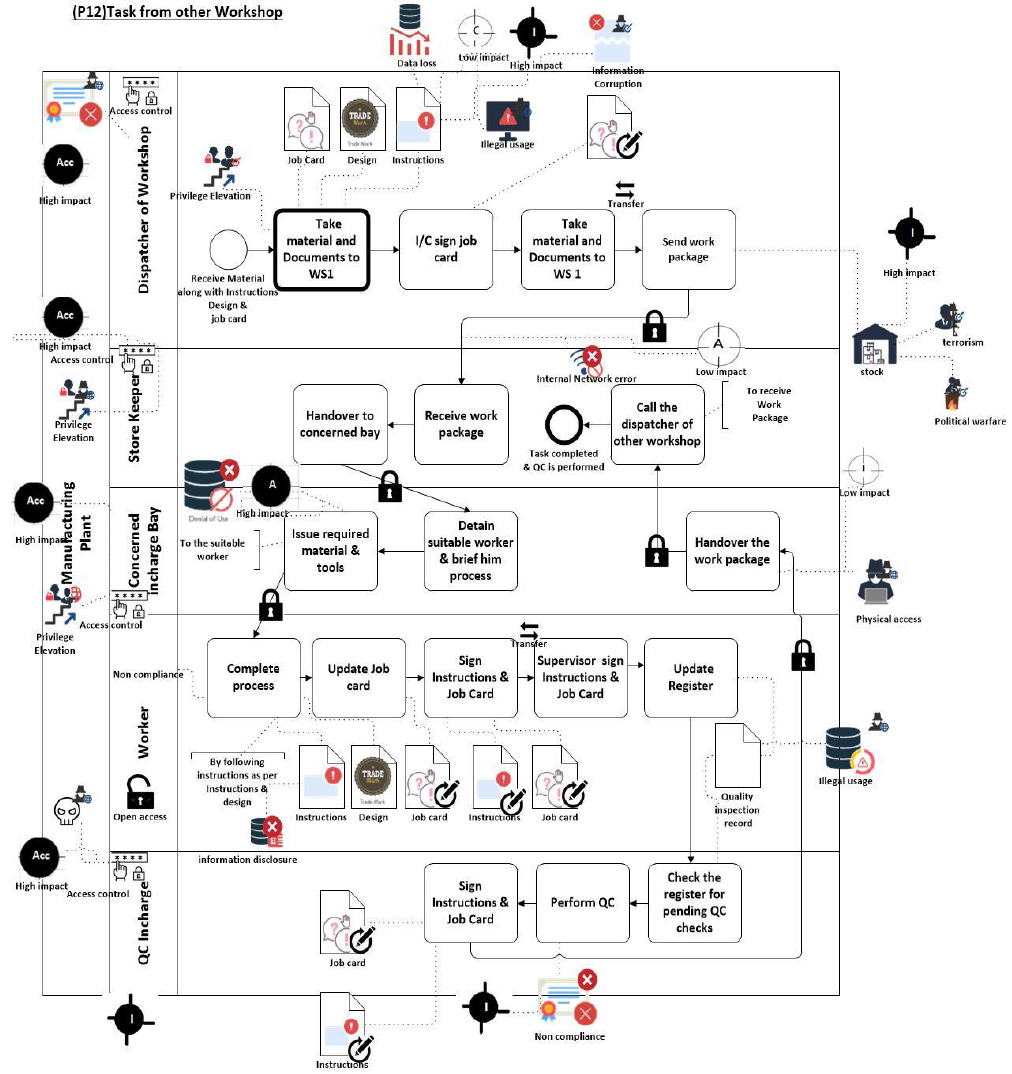
Figure 11. Receiving task from the other workshop and handing it to concerned bay using the proposed Business Process Management Notation (BPMN) extension.